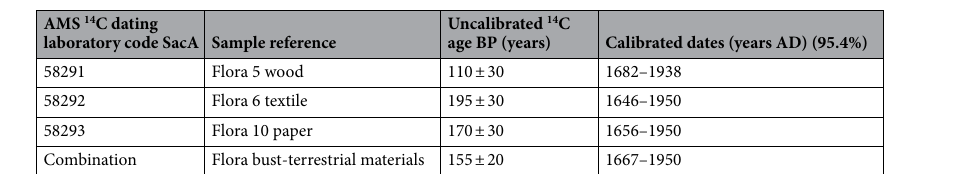
AMS 14 C dating laboratory code SacA Sample reference